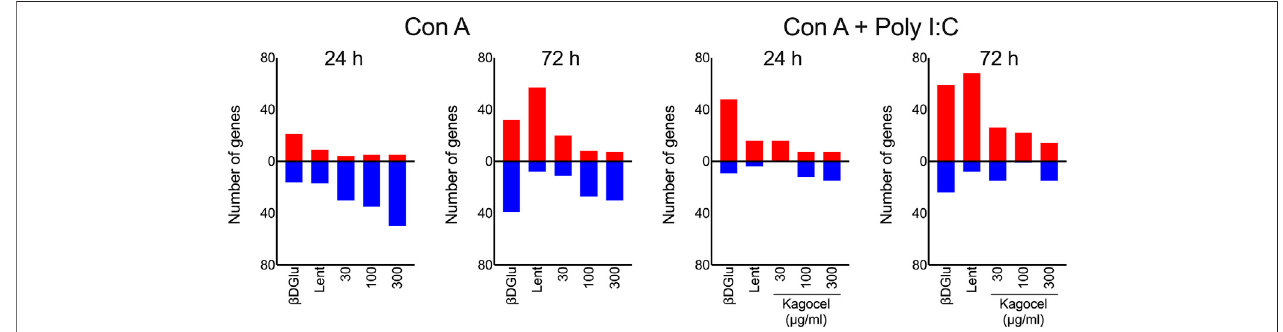
FIGURE2| Thecountsofup-(red)anddownregulated(blue)in fl ammation-relatedgenesinPeyer ’ spatcheslymphocytesstimulatedwithconcanavalinA(ConA)in absenceorpresenceofTLR-3ligandpolyI:C24and72 haftertreatmentwith300 μ g/mloats β -DGlucan( β DGlu),300 μ g/mllentinan(Lent)or30-300 μ g/mlkagocelas compared to control, saline-treated, lymphocytes. RNA was collected in 3 independent runs of the experiment.